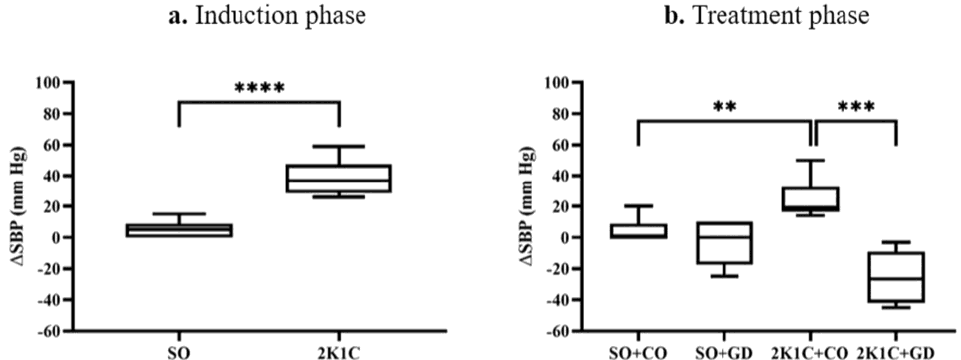
Figure 3. Changes in the tail-cuff BP ( ∆ SBP, mm Hg) of the sham-operative (SO) and 2K1C groups during the hypertension induction phase ( a ) and the GD flower extract treatment phase ( b ). Data are expressed as mean ± S.E.M. ** p < 0.01, *** p < 0.001, **** p < 0.0001 between groups.